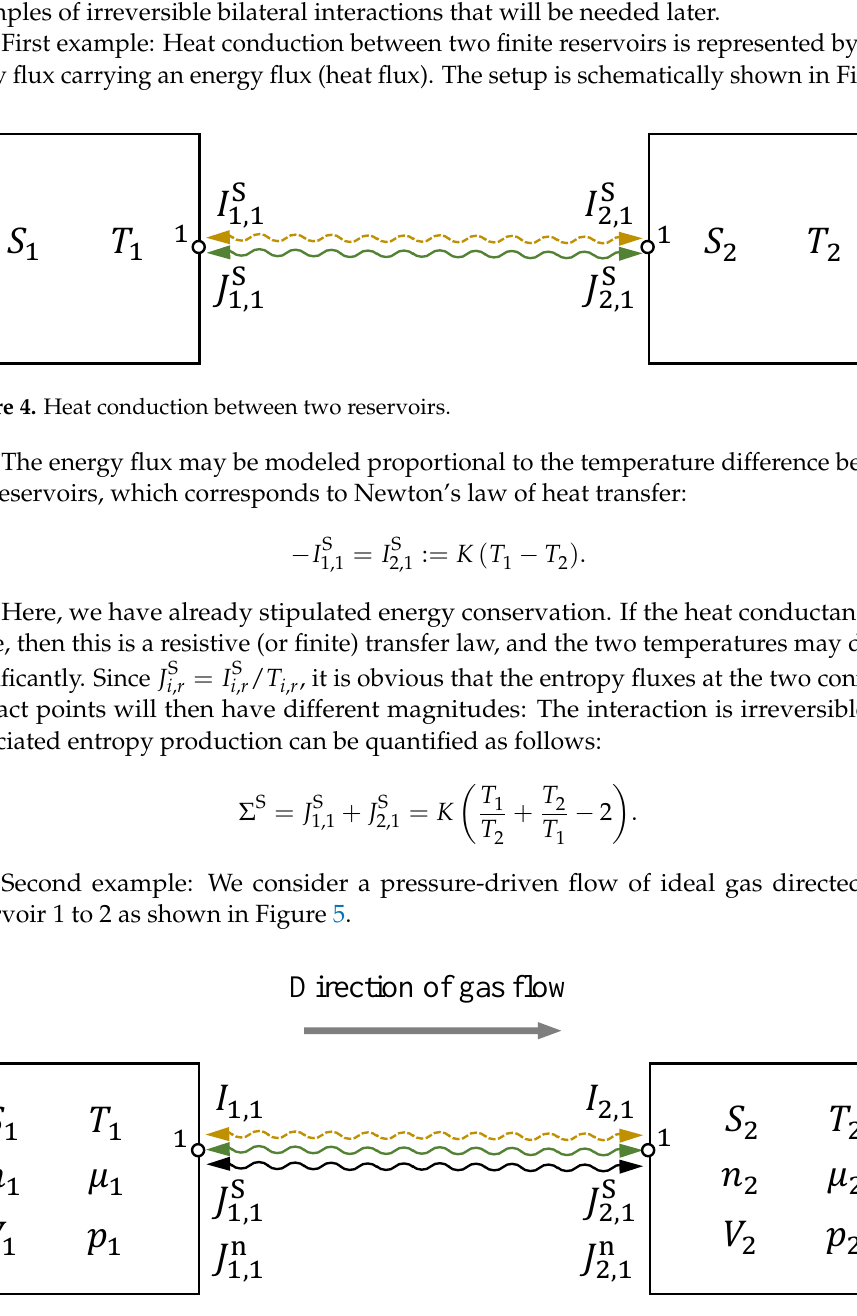
Figure 5. Gas flow between two finite ideal gas reservoirs. Considered flow direction: from reservoir 1 to reservoir